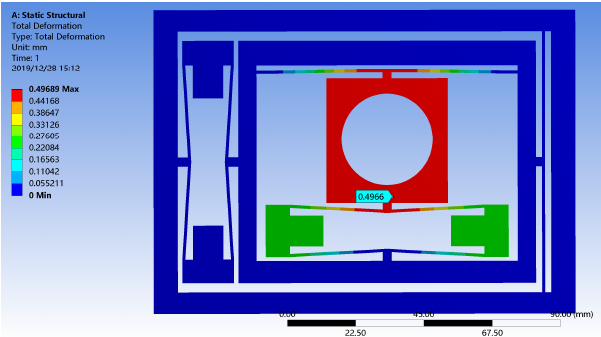
Figure 13. The displacement simulation of micro-positioning platform in the Y direction.